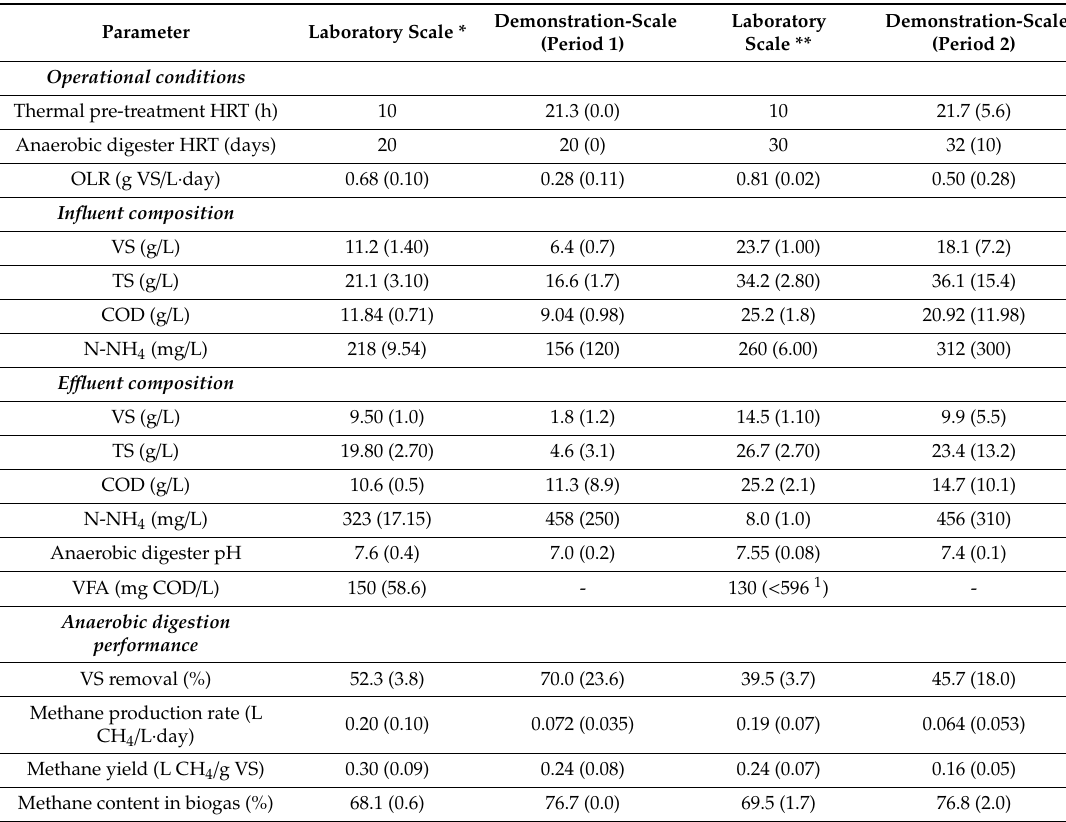
Anaerobic digestion performance for thermally pretreated microalgal biomass in laboratory-scale and pilot-scale reactors. Mean values (standard